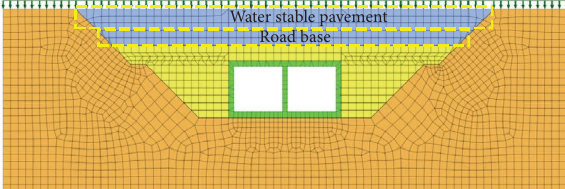
Figure 13: Diagram of the subgrade and water-stable layer.